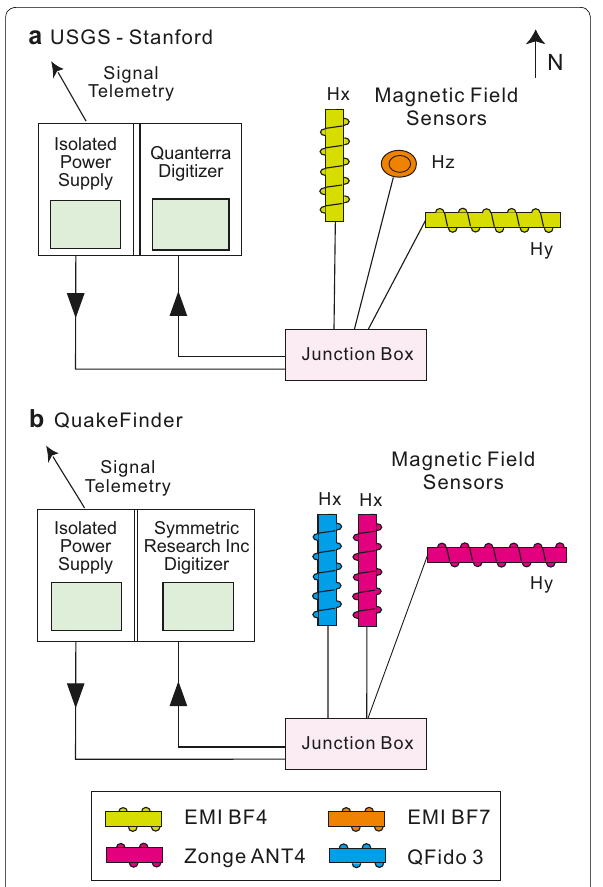
Fig. 3 Schematic equipment diagrams, as installed at JRSC: a USGS- Stanford and b QuakeFinder. H x , H y , and H z represent magnetic coils oriented in the magnetic north, magnetic east, and vertical directions, respectively. Note that the USGS-Stanford electric dipoles are not shown